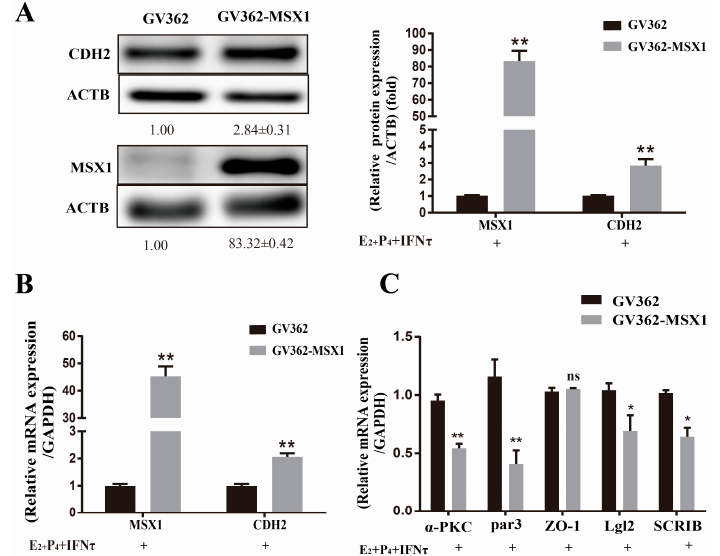
Figure 6. Overexpression of MSX1 enhanced the PMT. ( A ) Western blot and analysis results of CDH1 and MSX1 expression in the GV362-MSX1 group and GV362 plasmid group; ( B ) mRNA expression levels of CDH2 and MSX1 in the GV362-MSX1 group and GV362 plasmid group; ( C ) mRNA expression levels of ZO-1 , α -PKC , Par3 , SCRIB, and Lgl2 in the GV362-MSX1 group and GV362 plasmid group. ns: p > 0.05; * p < 0.05; ** p < 0.01.